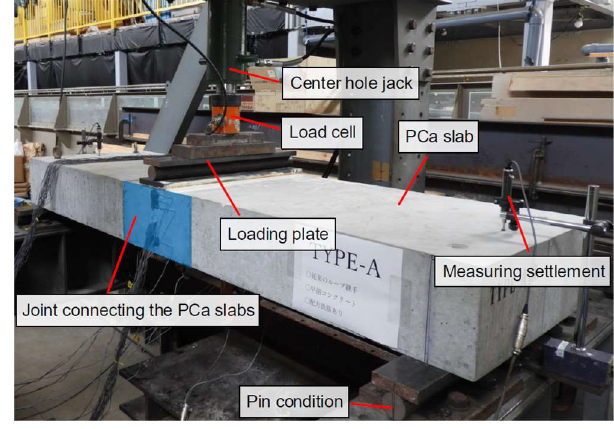
Figure 7. Setup for flexural loading test (Type A).